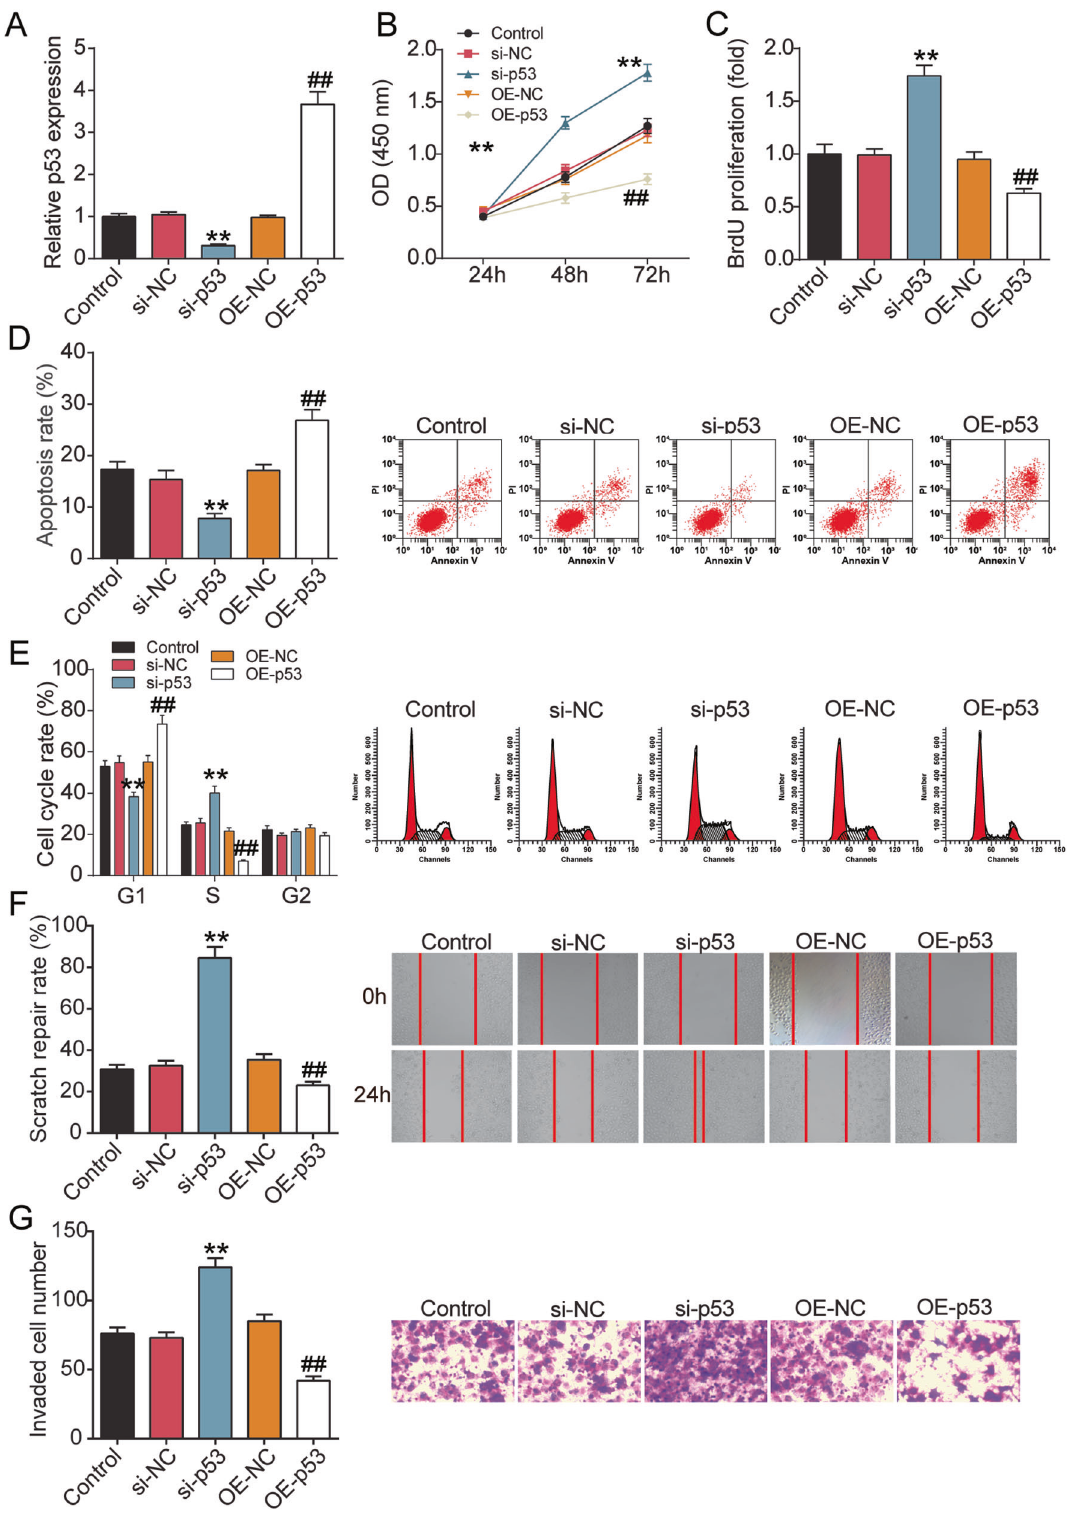
Fig. 5 Abnormal p53 expression affects trophoblast cell survival. A HTR-8/SVneo cells were transiently transfected with p53 pcDNA3.1 (OE- p53) or siRNA (si-p53) for 48 h. qRT-PCR analysis upregulated expression of p53. B CCK-8 assays were implemented to detect the viability of OE-p53 or si-p53-treated HTR-8/SVneo cells. C BrdU assays were implemented to detect the proliferation of OE-p53- or si-p53-treated HTR-8/ SVneo cells. D The apoptotic rates of HTR-8/SVne cells transfected with OE-p53 or si-p53 were measured by fl ow cytometry. E The cell cycle of HTR-8/SVne cells transfected with OE-p53 or si-p53 was measured by fl ow cytometry. F Wound scratch assay was performed to detect the role of OE-p53- or si-p53-treated HTR-8/SVne cell migration in vitro. G Transwell assays were performed to detect the invasion of HTR-8/SVne cells transfected with OE-p53 or si-p53. ** P < 0.001 compared with si-NC. ## P < 0.001 compared with OE-NC. N = 3, repetition = 3.